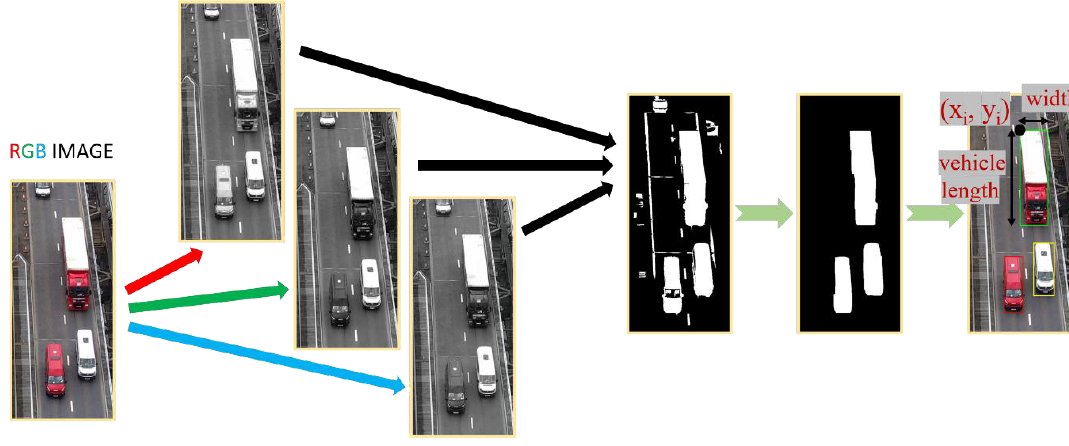
Figure 2. Vehicle length measured in images: primary intensities (red, green, blue) extracted from colour image and represented as individual grey images; results of red, green and blue intensities applied together; vehicle outlines identified and enclosed in rectangles [41].